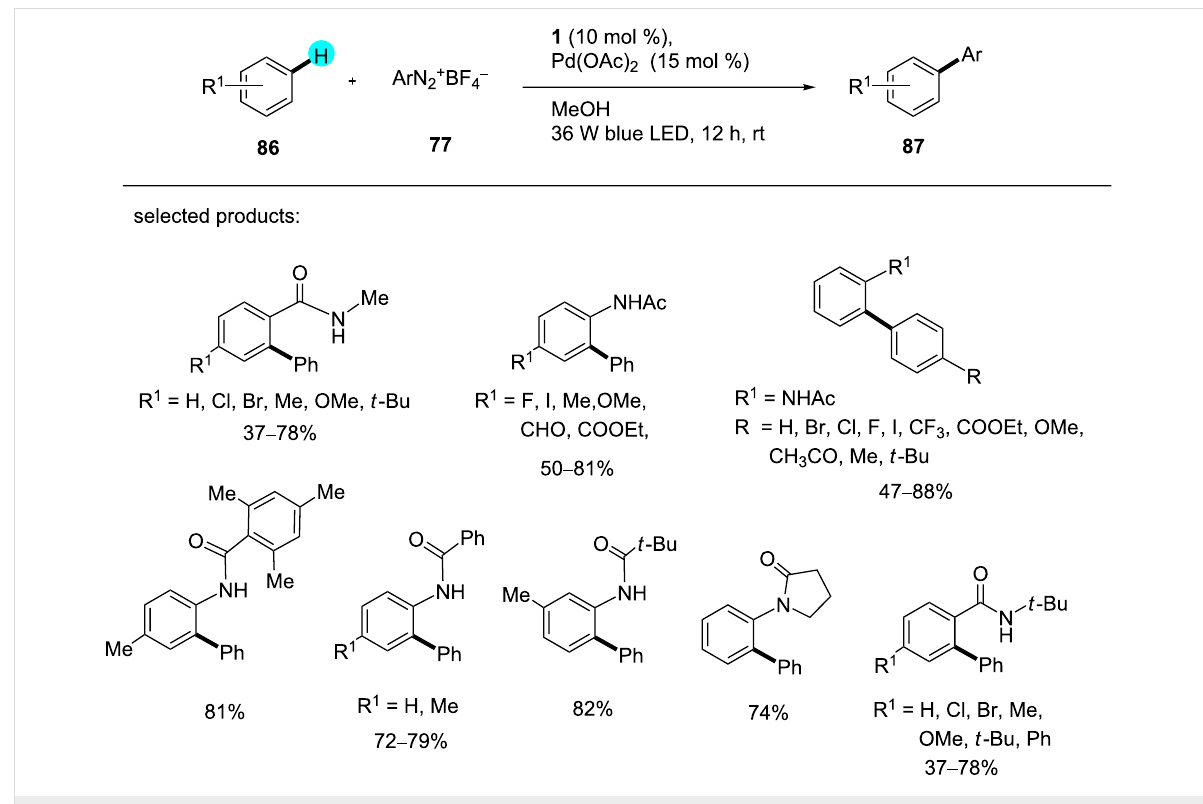
Scheme 12: Arylation of substituted arenes with an organic photoredox catalyst.